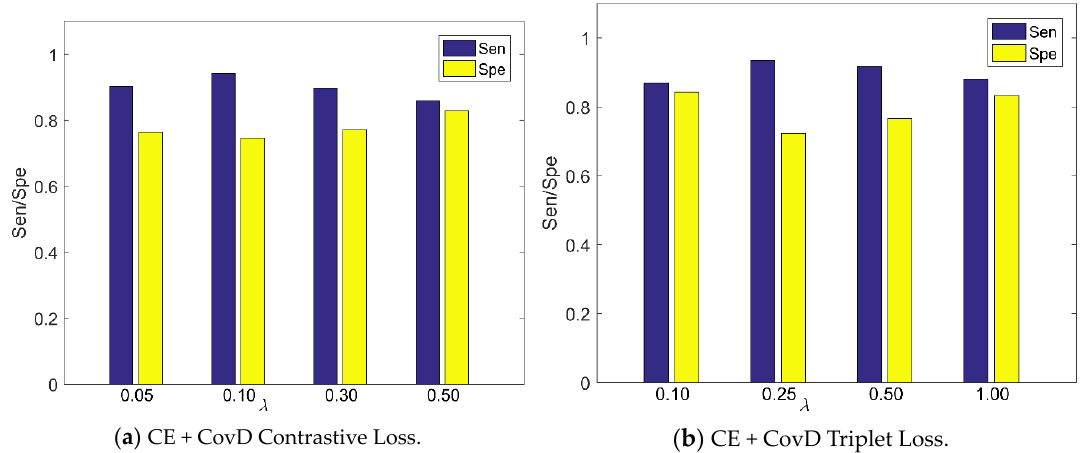
Figure 3. The e ff ect of λ on our method using CE + CovD Figure 3. The effect of  on our method using CE + CovD loss.